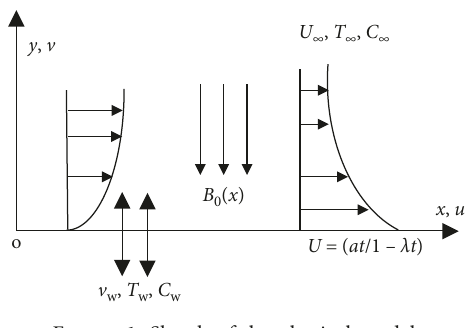
Figure 1: Sketch of the physical